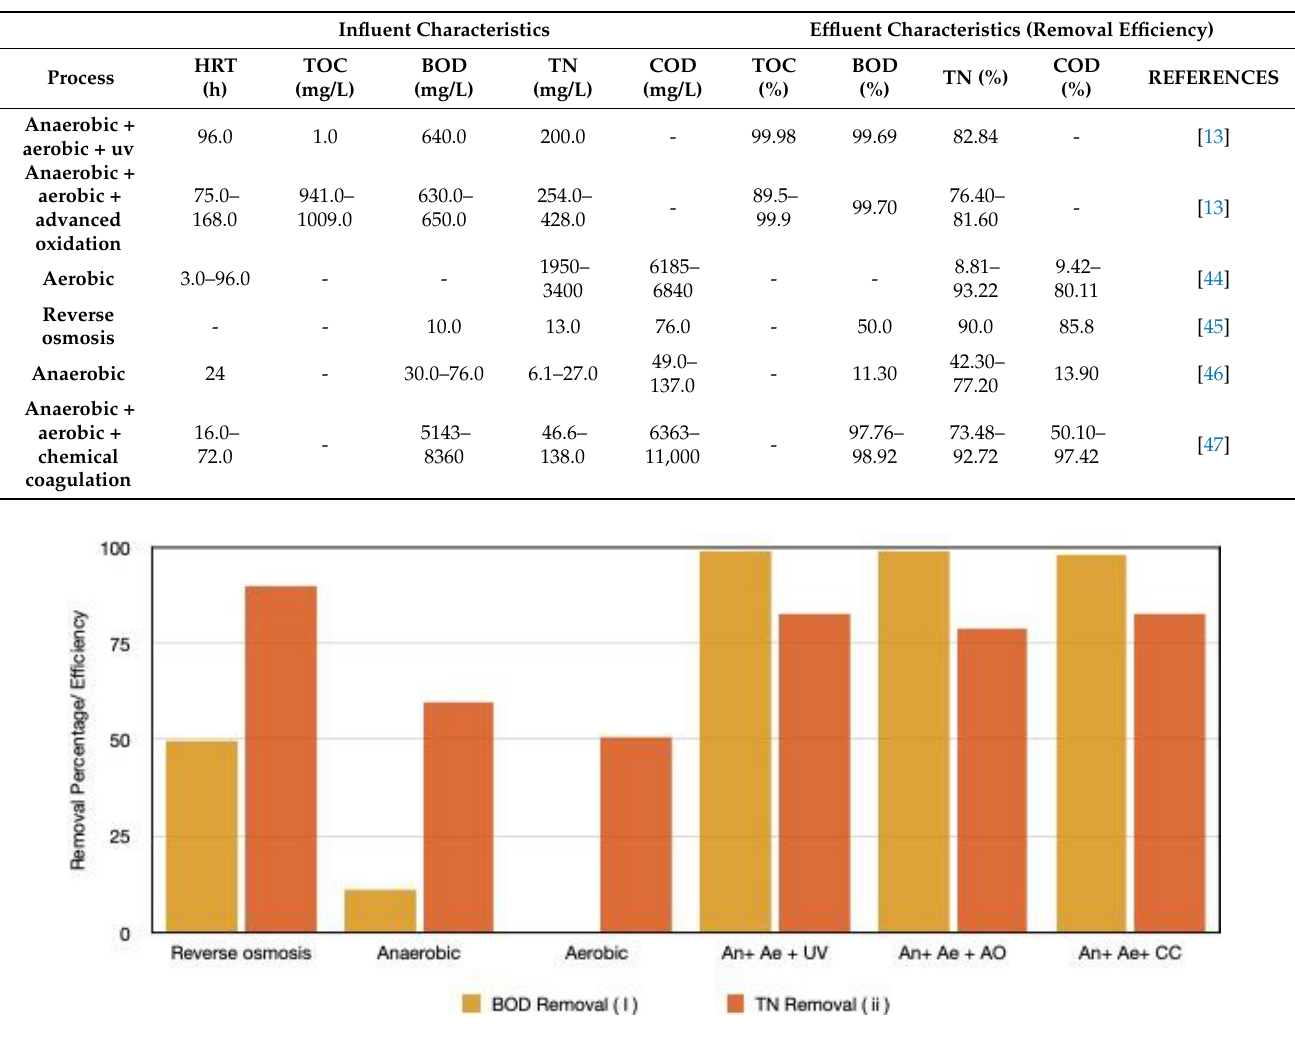
Table 3. Comparison between effluent qualities of single systems vs. multi-integrated systems.